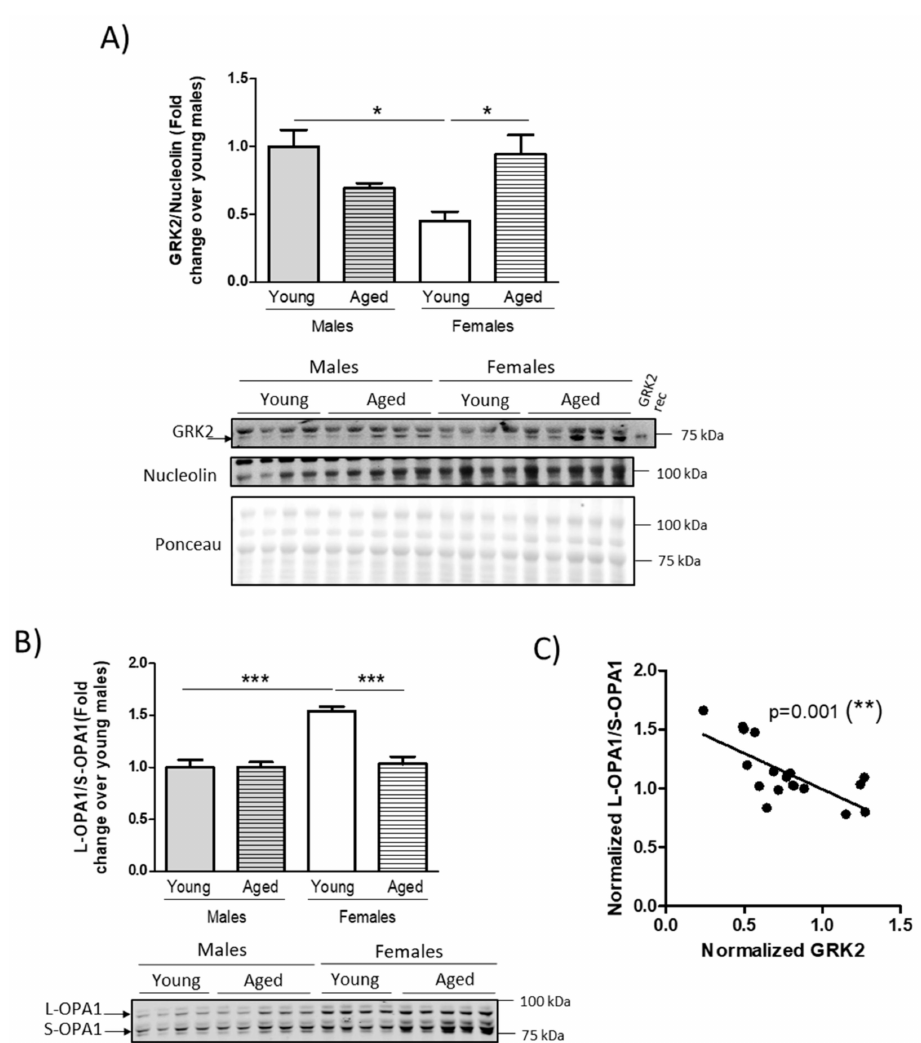
Figure 1. Age-associated changes in G protein-coupled receptor kinase 2 (GRK2) protein levels in the heart differ in male and female mice and inversely correlate with the mitochondrial fusion marker optic atrophy (OPA1) isoform ratio. Cardiac tissue lysates from C57BL/6 J mice of 4 months (young) or 15 months (aged) of age were analyzed by Western blot to quantify GRK2 protein levels ( A ), OPA1 isoform ratio ( B ), and nucleolin used as a loading control. Equal protein amounts among (Western blot) WB lanes was confirmed by Ponceau staining. Electrophoretic migration of molecular weight markers is indicated. Correlation between GRK2 ( A ) and the L-OPA1/S-OPA1 ratio ( B ) was assessed by Pearson’s correlation ( C ). Representative immunoblots and densitometric analysis correspond to n = 4–5 mice per condition. Results are represented as means ± SEM. Statistical significance was analyzed by one-way ANOVA corrected by Bonferroni’s post-test and Pearson’s correlation. * p < 0.05, ** p < 0.01, *** p < 0.001. GRK2 Rec, recombinant purified GRK2 protein from infected overexpressing Sf9